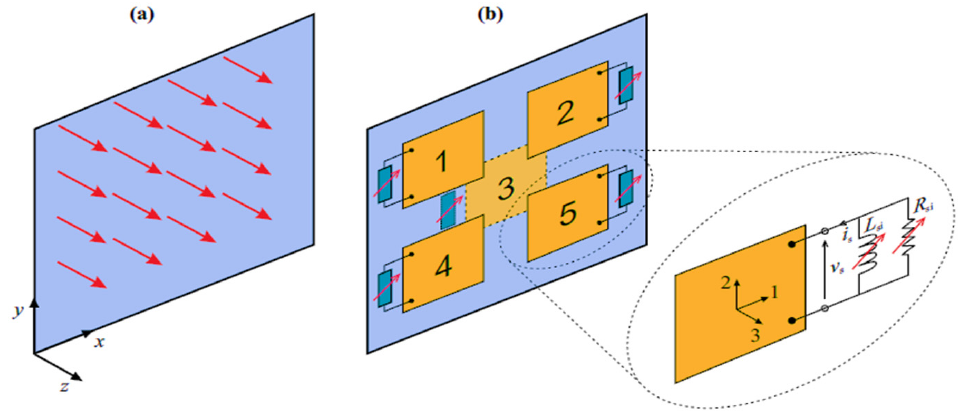
Figure 2. Vibration plate with shunted piezoelectric patches. Reprinted from [36], Copyright 2021, with permission from Elsevier.